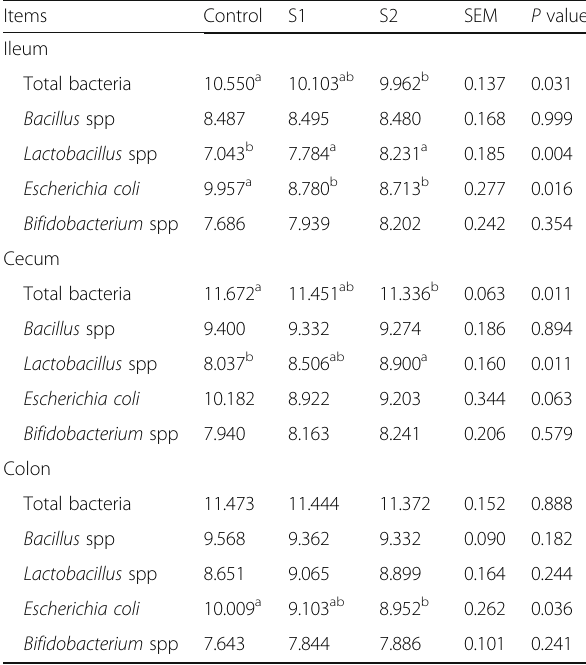
Table 7 Effect of gastric infusion of SCFA on the ileal, caecal, and colonic Escherichia coli , Lactobacillus spp, Bifidobacterium spp, and Bacillus spp in weaned piglets (log copies/g)